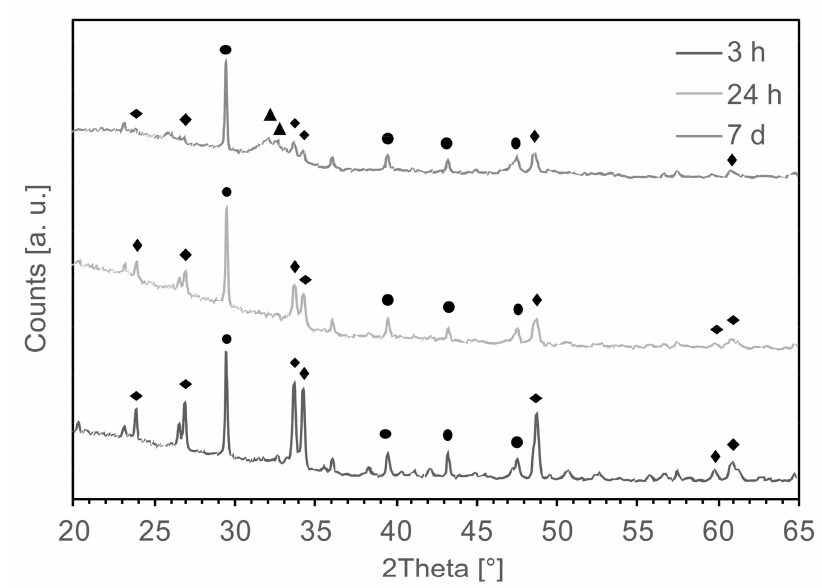
Figure 10. XRD analyses performed after 3 h, 24 h, and 7 d of immersion in SBF on foams aged 4 weeks. ( (cid:117) ) = Na 2 Ca 2 Si 3 O 9 [JCPDS #98-006-0502]; ( (cid:8) ) = CaCO 3 [JCPDS #98-002-0179]; ( (cid:78) ) = Hydroxyapatite carbonate (HAC) [JCPDS #98-015-0310].